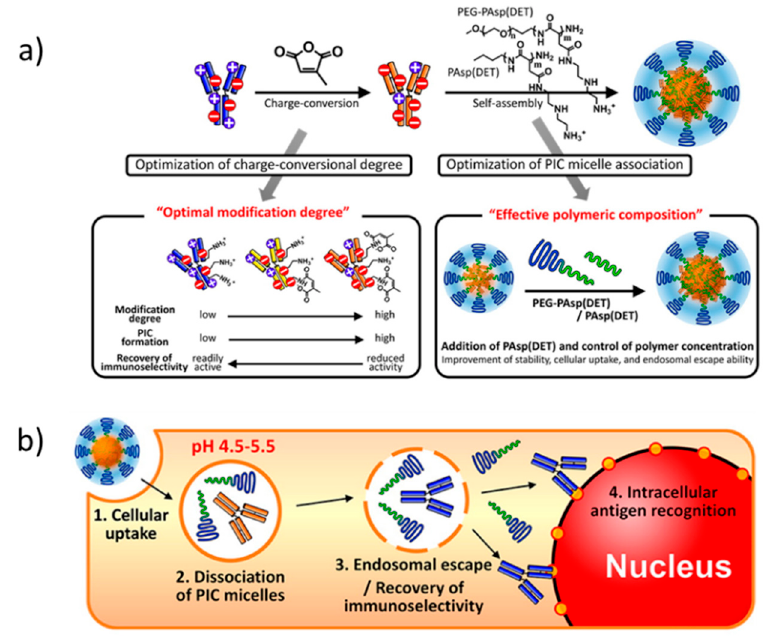
Figure 4. ( a ) Charge conversion of immunoglobulin with citraconic anhydride and subsequent C3M formation with poly(ethylene glycol) (PEG)- b -PAsp(DET) block copolymer and PAsp(DET) homopolymer. ( b ) schematic mechanism for C3M cell internalization, dissociation, and recovery